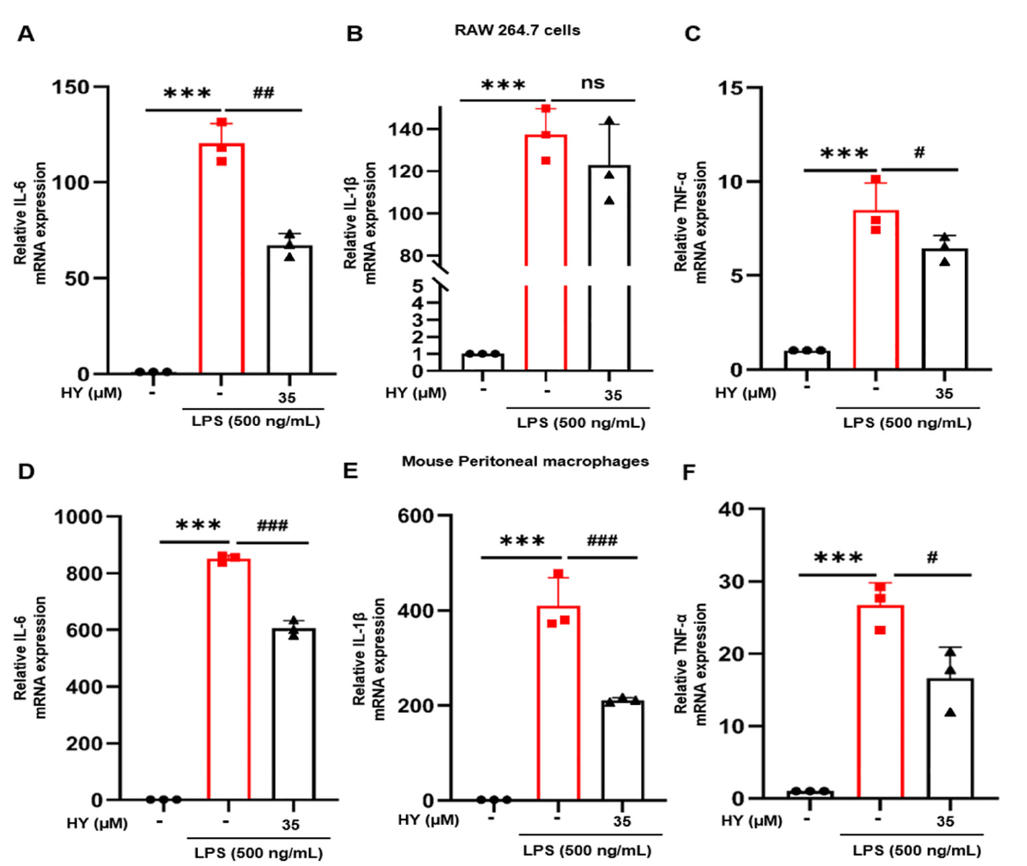
Figure 3. ( A – C ) Real-time quantitative polymerase chain reaction (RT-qPCR) for the expression of interleukin-6 (IL-6), interleukin-1 β (IL-1 β ), and tumor necrosis factor- α (TNF- α ) on lipopolysaccharide (LPS)-stimulated RAW 264.7 cells. ( D – F ) RT-qPCR for the expression of IL-6, IL-1 β , and TNF- α on LPS-stimulated mouse peritoneal macrophages. Following pre-treatment with 35 µ M hyssopuside (HY) for 1 h, RAW264.7 cells and mouse peritoneal macrophages were treated with or without 500 ng/mL LPS for 12 h. The total RNA was prepared, and the mRNA expression of IL-6, IL-1, and TNF- α were detected by RT-qPCR. Data are representatives of three replicates and shown as mean ± SD. *** p < 0.001 versus the control group; # p < 0.05, ## p < 0.01, ### p < 0.001 versus the LPS-treated group; ns: no significance versus the LPS-treated